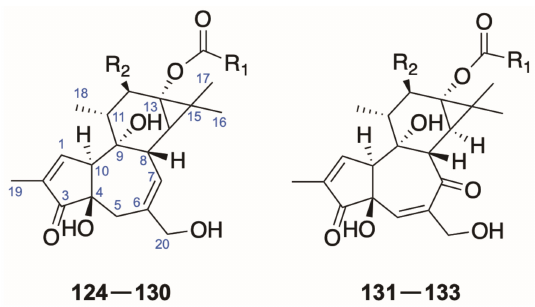
Figure 8. Structures of tigliane-type diterpenoids ( 124 – 133